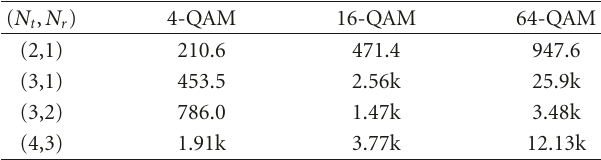
Table 3: The average number of flops for planar detection with J = 20.